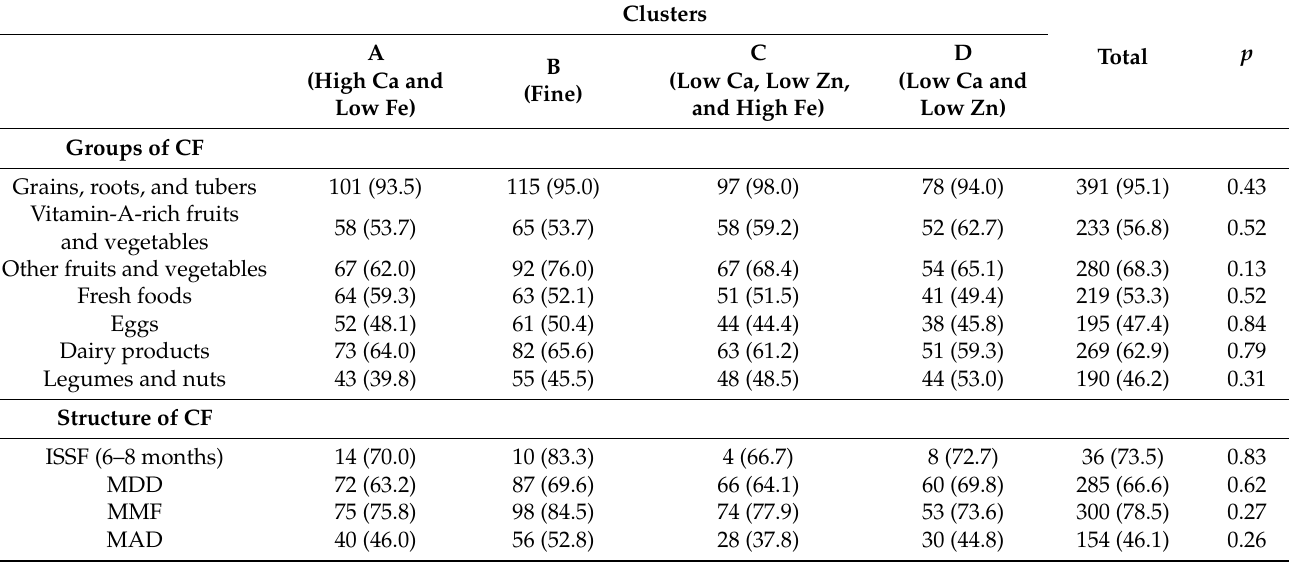
Table 5. The CF status in IYC with different micronutrient contents in hair.